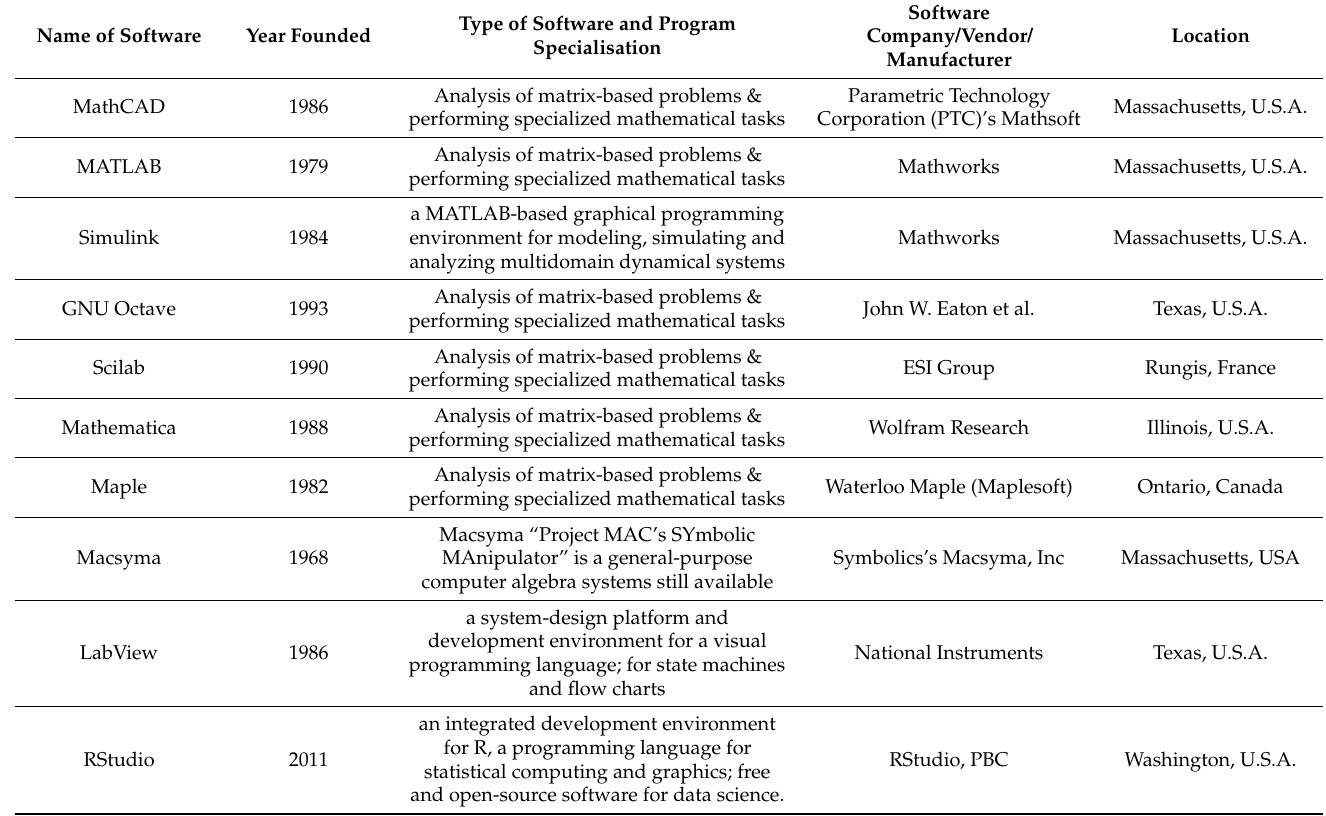
Table 7. Table of some mathematical codes, and programming software programs with developer